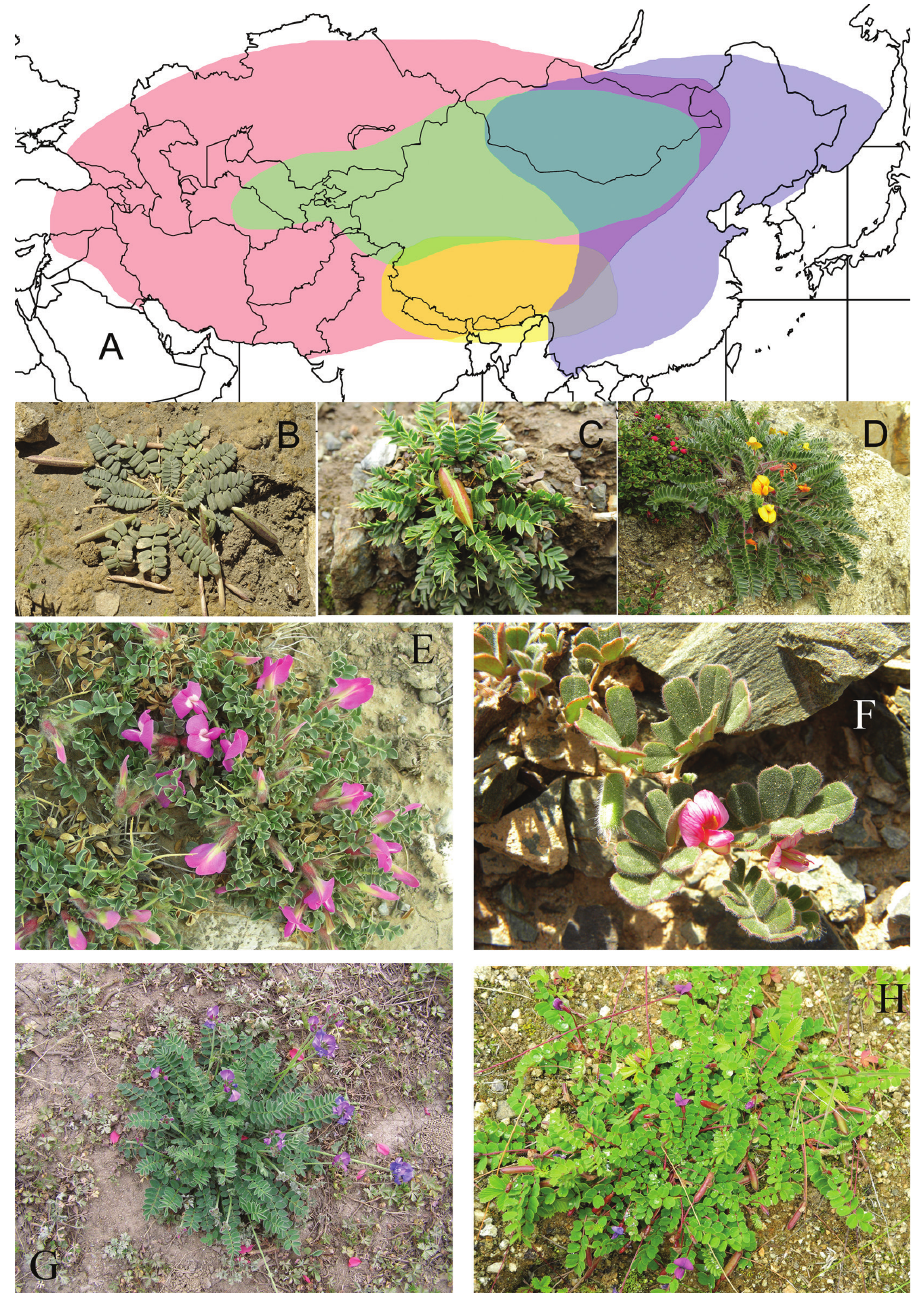
Figure 3. Distribution ( A ) and representative plants ( B–H ) of genera in Chesneyinae. A red – Chesneya , green – Chesniella , blue – Gueldenstaedtia and yellow – Tibetia B Chesneya acaulis C Chesneya spinosa D Chesneya nubigena E Chesniella macrantha F Chesniella ferganensis G Gueldenstaedtia verna H Tibetia yadongensis